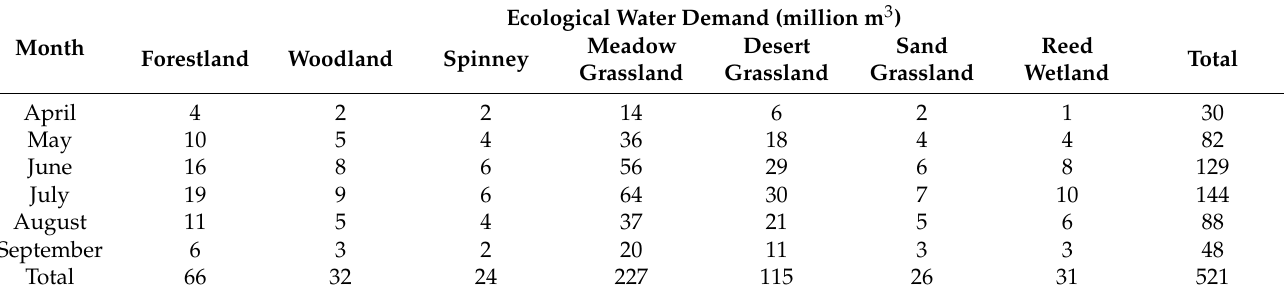
Table 3. Ecological water demand of valley forests and grasslands in the study